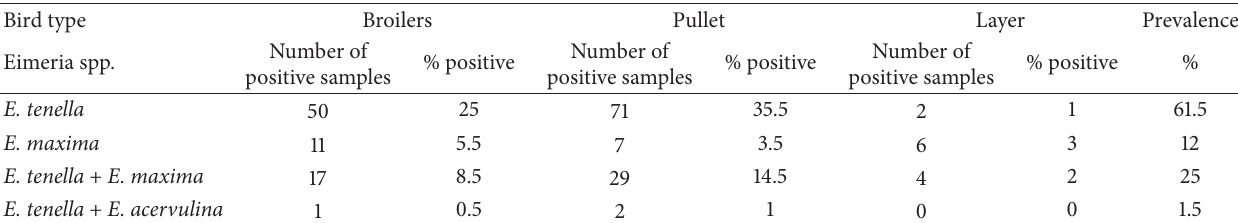
Table 4: Seasonwise prevalence of coccidiosis in free-range chicken in Sidi Thabet, Tunisia. Number of Season